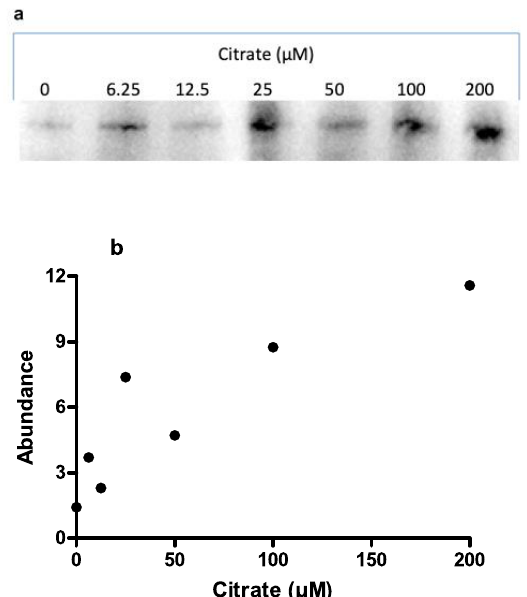
Figure 4. ( a ) Citrate recovered from ΔF508 -CFTR cell surface expression as analysed by Western blotting. ( b ) relative abundance of cell surface-expressed ΔF508 -CFTR.